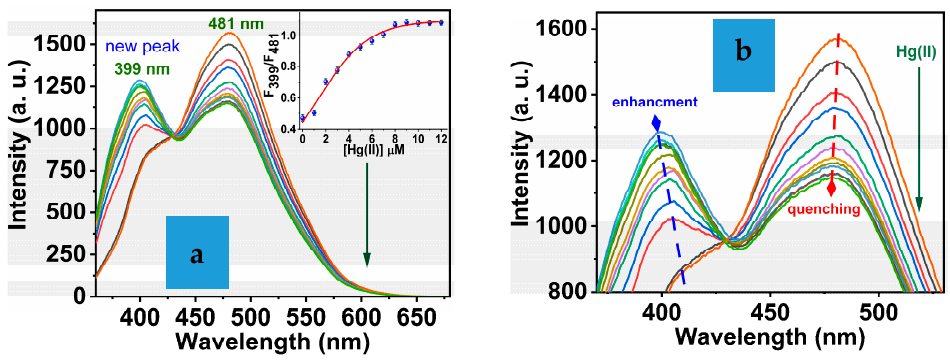
Figure 5. ( a ) Fluorescence titration of Hg(II) ‐ IXZD with a molar ratio of 0:1 (metal: IXZD); inset fig ‐ ure represents the IXZD emission intensities ratio at 399 and 481 nm versus [Hg(II)]; ( b ) IXZD emis ‐ sion intensities scope at 399 nm and 481 nm, respectively.